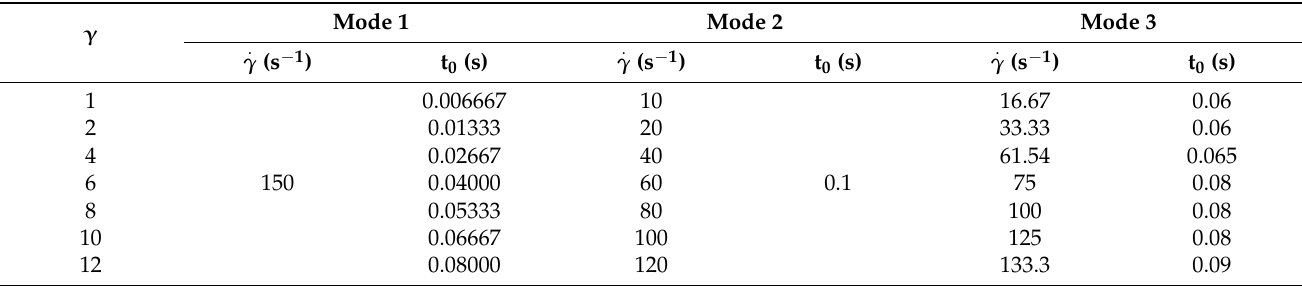
Table 1. Three modes of applying the shear